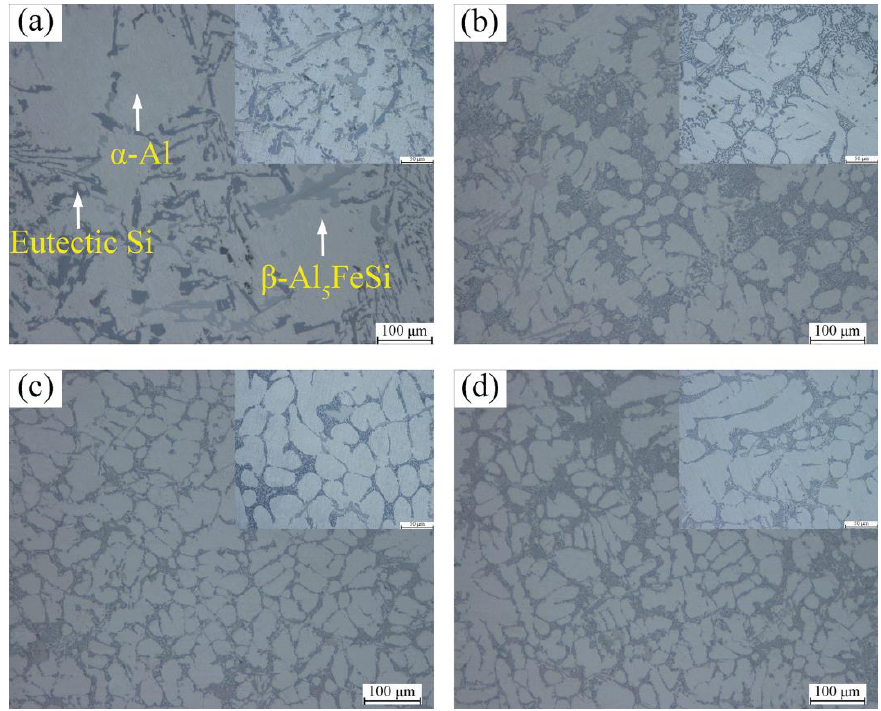
Figure 2. High magnification OM images of cast A380 alloys with different (La+Y) contents: ( a ) un- modified alloy; ( b ) 0.3 wt.%; ( c ) 0.6 wt.%; ( d ) 0.9 wt.%.